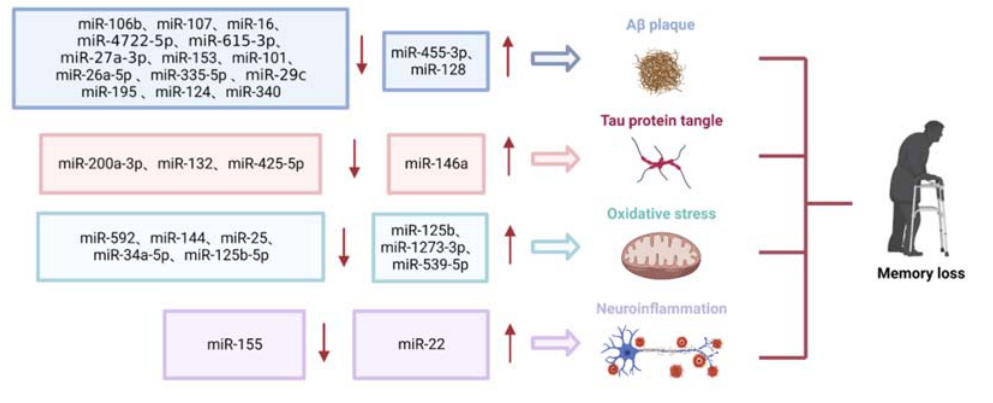
Figure 4. MiRNAs abnormally expressed miRNAs in AD